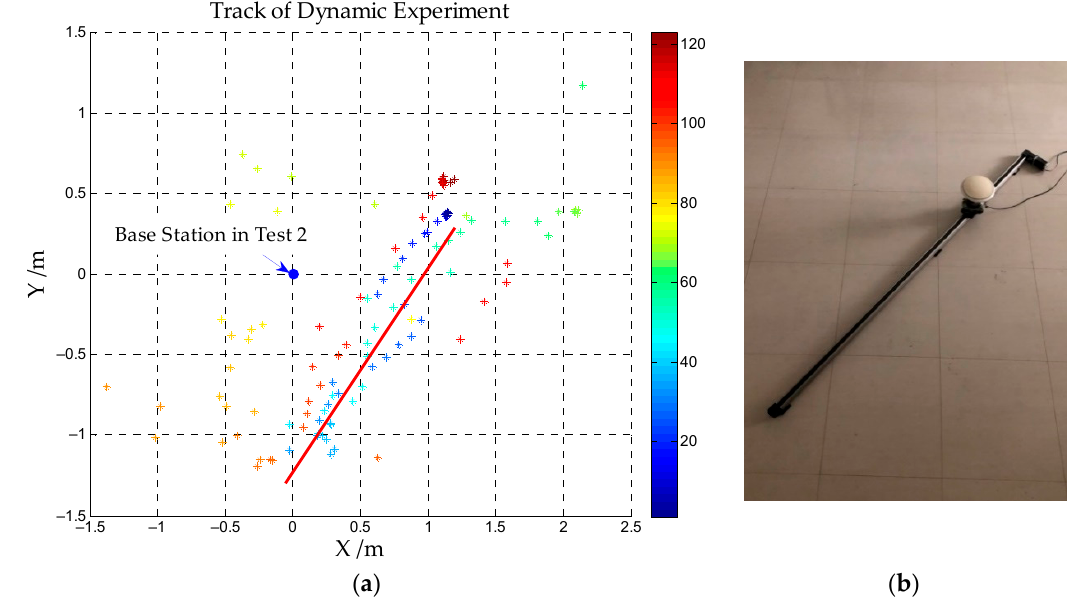
Figure 10. ( a ) The trajectory of Experiment 2, ( b ) The Equipment of Experiment 2.